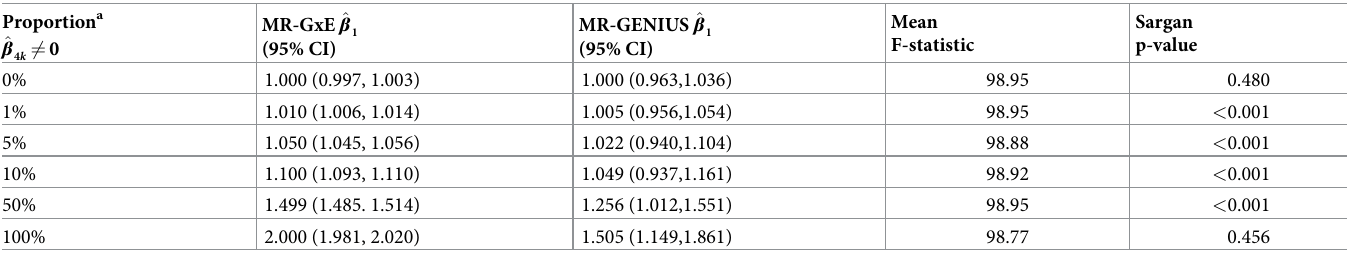
Table 4. Simulated results illustrating use of Sargan test to identify GxE3 violation (simulation 6). Proportion a ^ β 6¼ 4 k